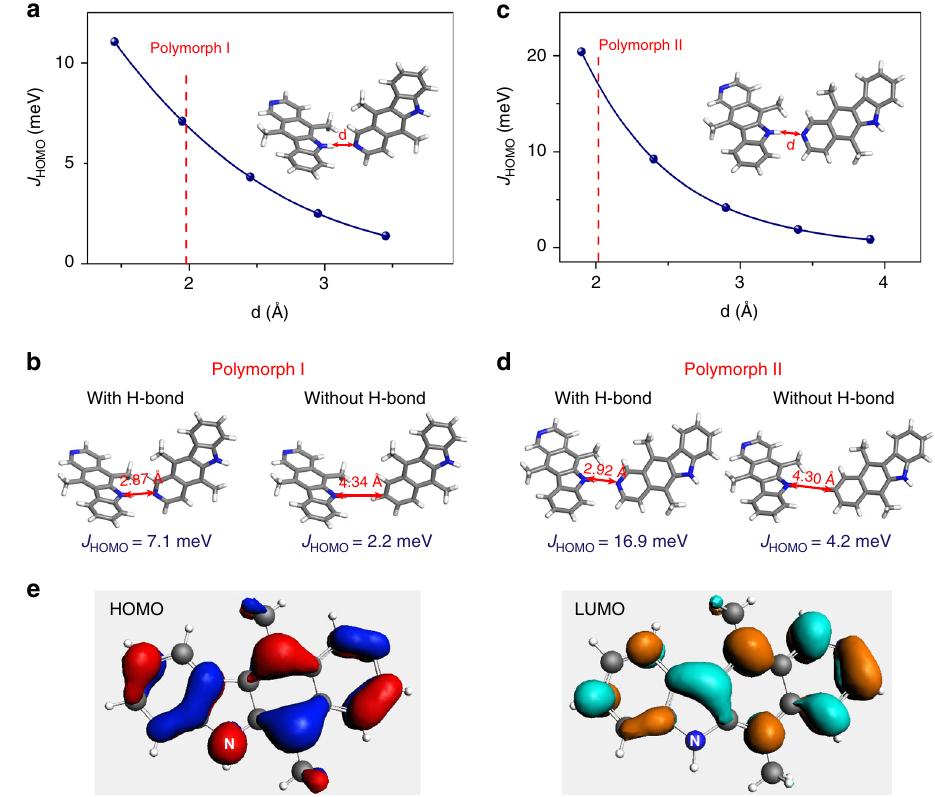
Fig. 3 Theoretical calculations on the role of H-bond on electronic coupling. a , c Calculated hole transfer integral along the H-bonding direction as a function of NH … N distance for ellipticine with polymorph I and II. See Methods section for details. b , d Comparison of hole transfer integrals with and without H-bond for two polymorphs. The molecular pair without H-bond was created by replacing N with CH. Removal of H-bond requires adjustment of intermolecular distance from the original ~ 2.9 Å (N to N) to 4.3 Å (N to C) so that the two hydrogen atoms are separated by the sum of their van der Waals radii. We note that an intermolecular distance of 2.87 Å and 2.92 Å (N to N) corresponds to a H-bond length of 1.95 Å and 2.02 Å (N to H) in a for polymorph I and II, respectively. e Frontier molecular orbital topologies of ellipticine comparing the contribution of NH to HOMO vs. LUMO. The nitrogen atoms in the NH bonds are labeled in the HOMO and LUMO to facilitate direct comparison. Please note that this is a single molecule calculation